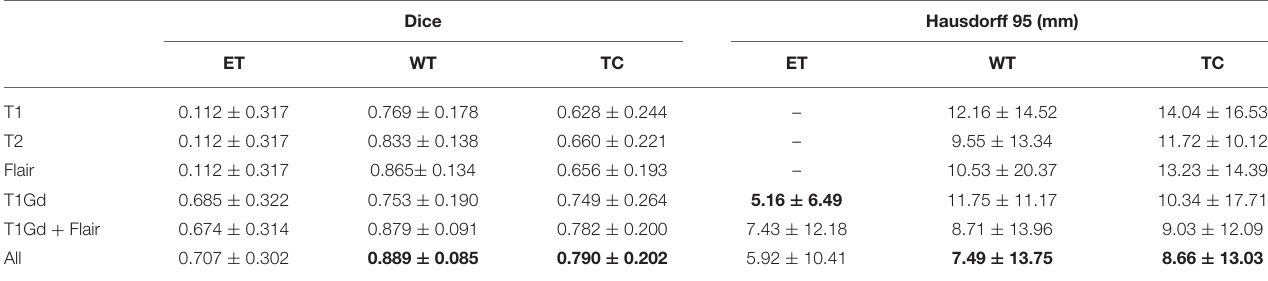
TABLE 5 | Single input results on BraTS 2019 validation data (125